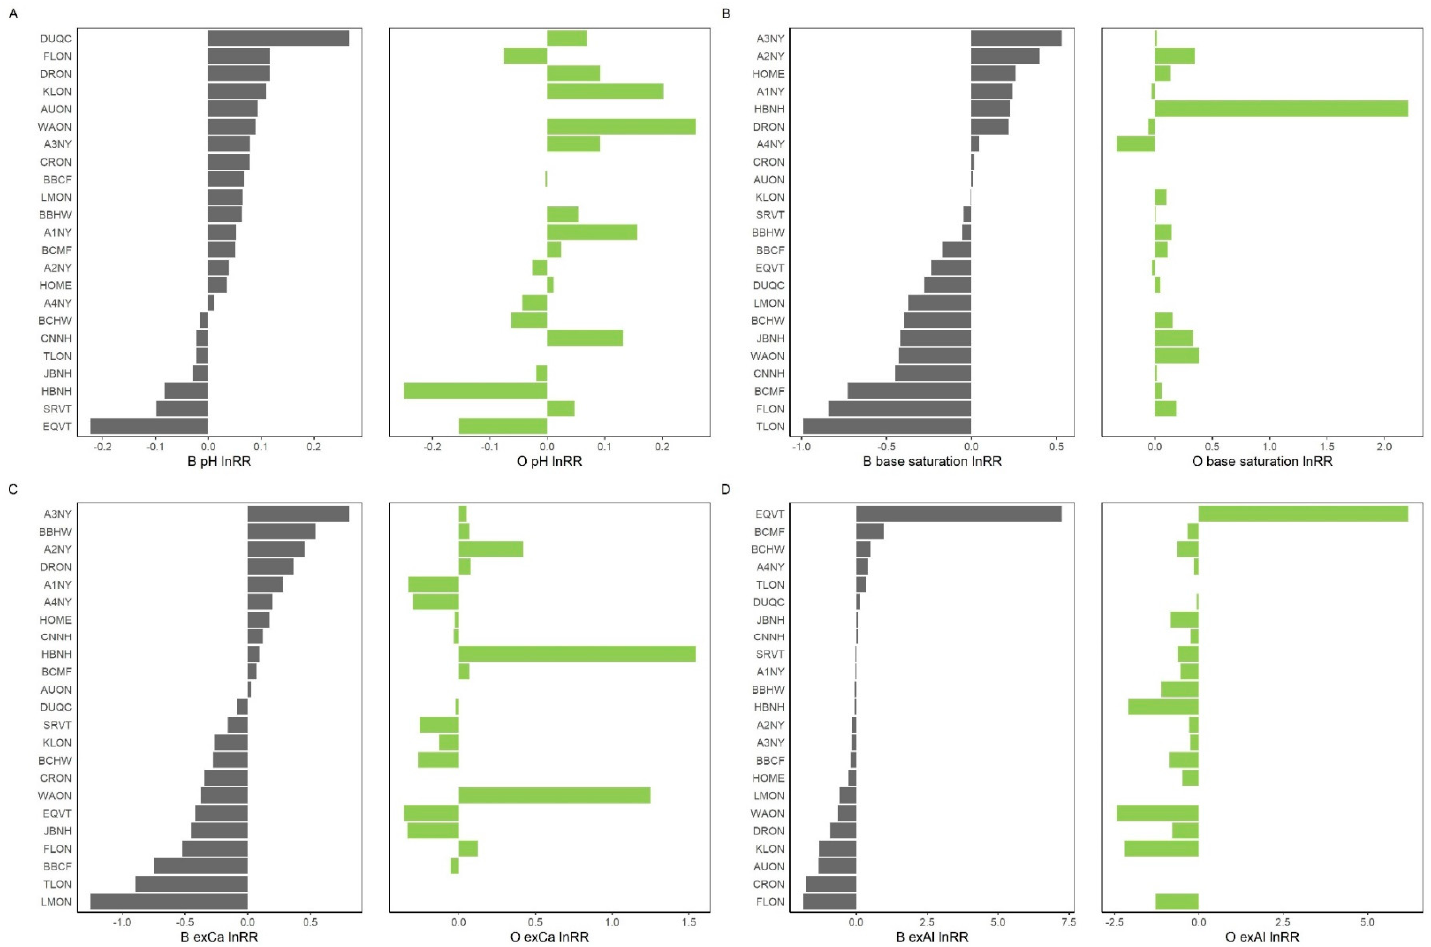
Figure 5. Recovery indices (ln [final sampling / initial sampling]) for ( A ) pH, ( B ) base saturation, ( C ) exchangeable Ca and ( D ) exchangeable Al for the B and O horizons for soil resampling sites in Eastern Canada and the Northeastern United States.